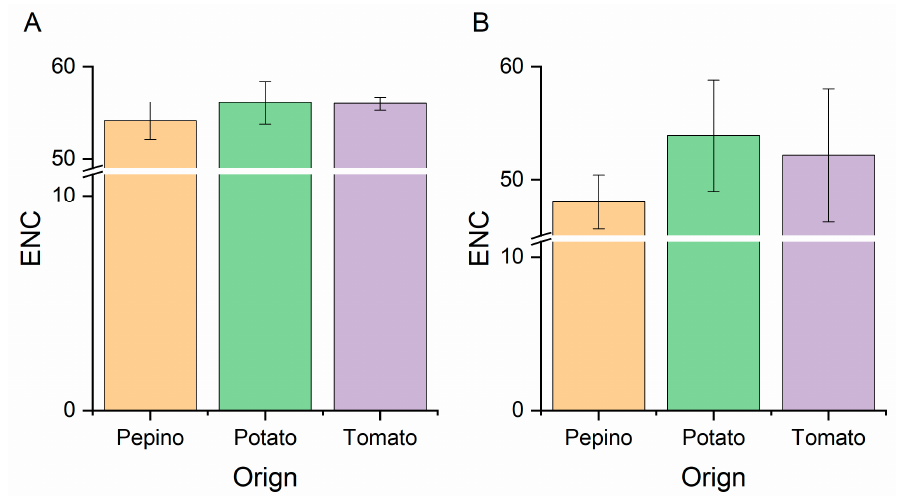
Figure 1. Effective Number of Codons (ENC) values of the CP ( A ) and NABP ( B ) genes of PVM from different hosts. The pepino, potato and tomato hosts are represented in light orange, light green and light purple, respectively.